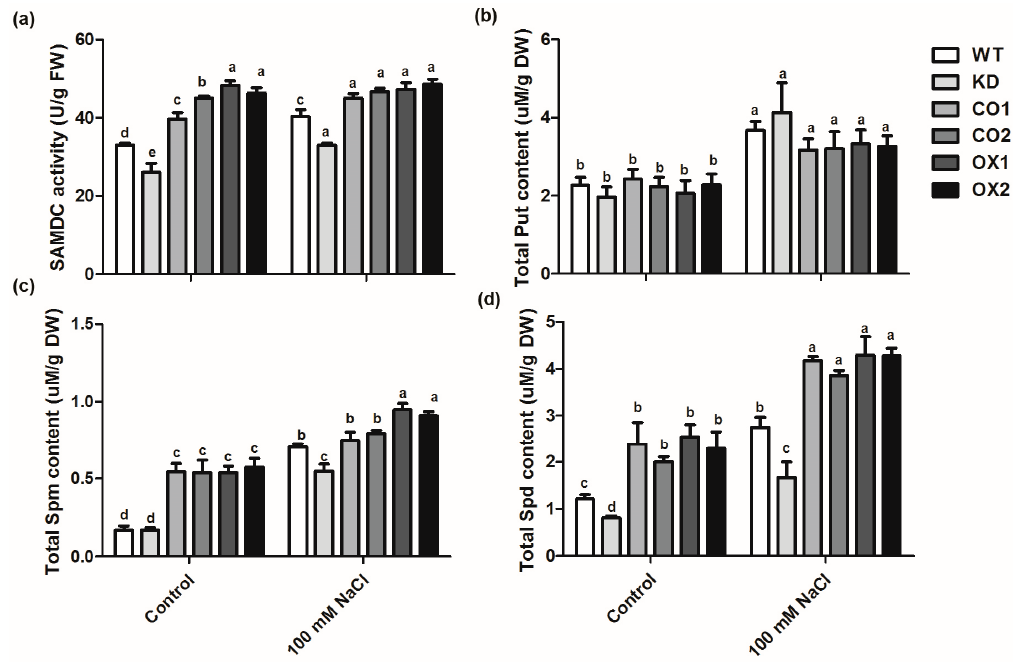
Figure 5. Effects of salt stress on polyamine metabolism in the leaves of wild type (WT), BvM14-SAMDC -overexpression in WT Arabidopsis (OX), atsamdc1 mutant (KD) and transgenic BvM14-SAMDC in the mutant seedlings (CO). ( a ) SAMDC activity; ( b ) levels of putrescine (Put); ( c ) levels of spermine (Spm); and ( d ) levels of spermidine (Spd) under control and salt stress (100 mM NaCl) conditions. One unit of SAMDC activity was defined as the amount of enzyme required for catalyzing 2 μ mol SAM within 1 min. Different letters indicate significantly different at P < 0.05. Three biological replicates were performed.